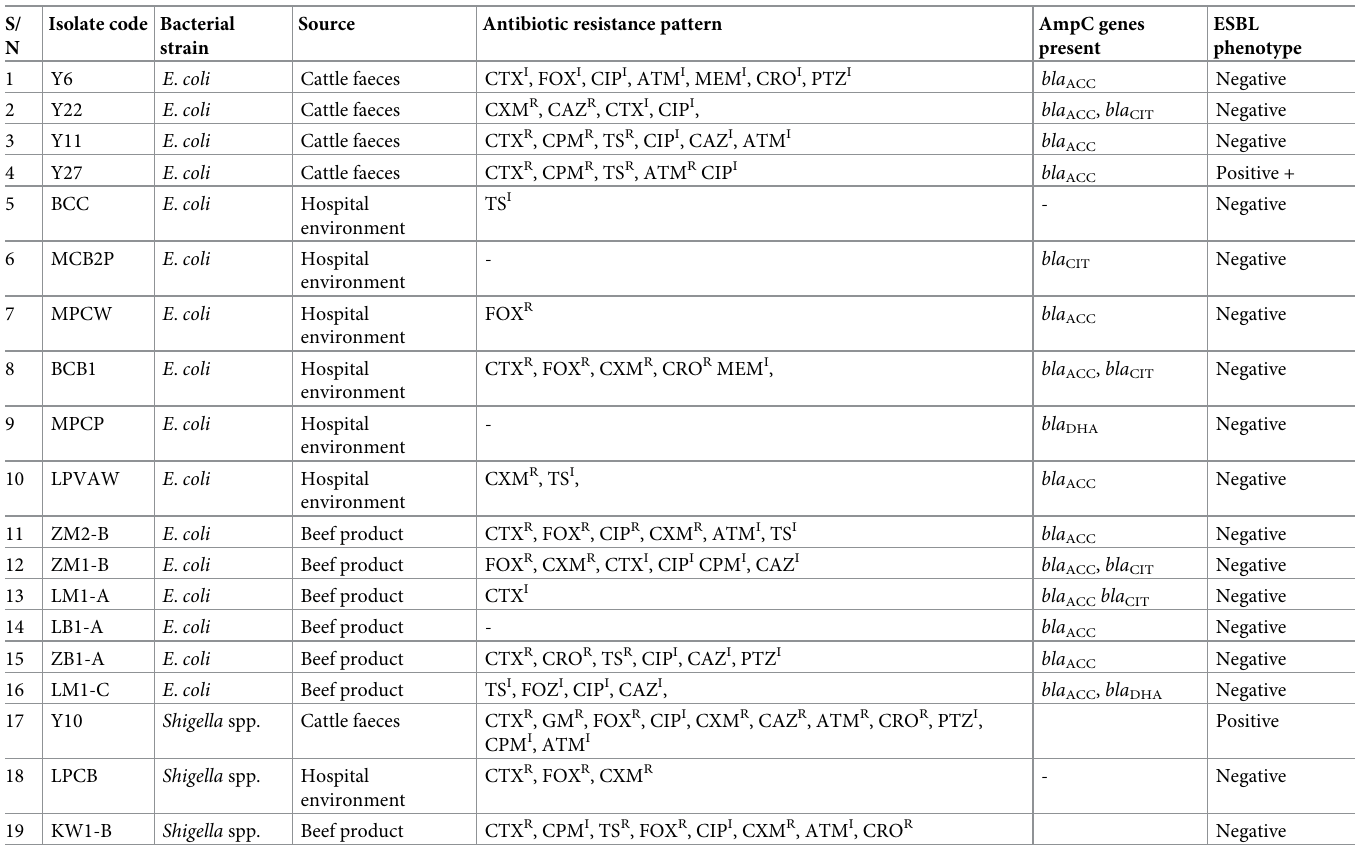
Table 6. Summary characteristics of AmpC beta-lactamase positive Enterobacteriaceae